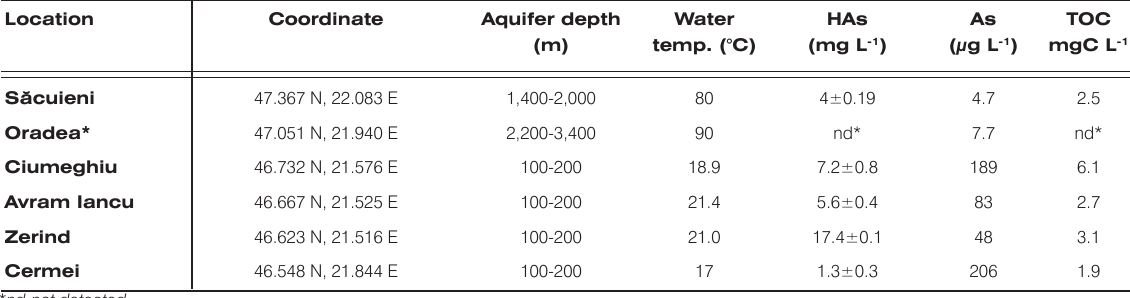
Figure 5. HAs concentration versus TOC level (A) and total arsenic content (B). Table 4. Determination of HAs in natural